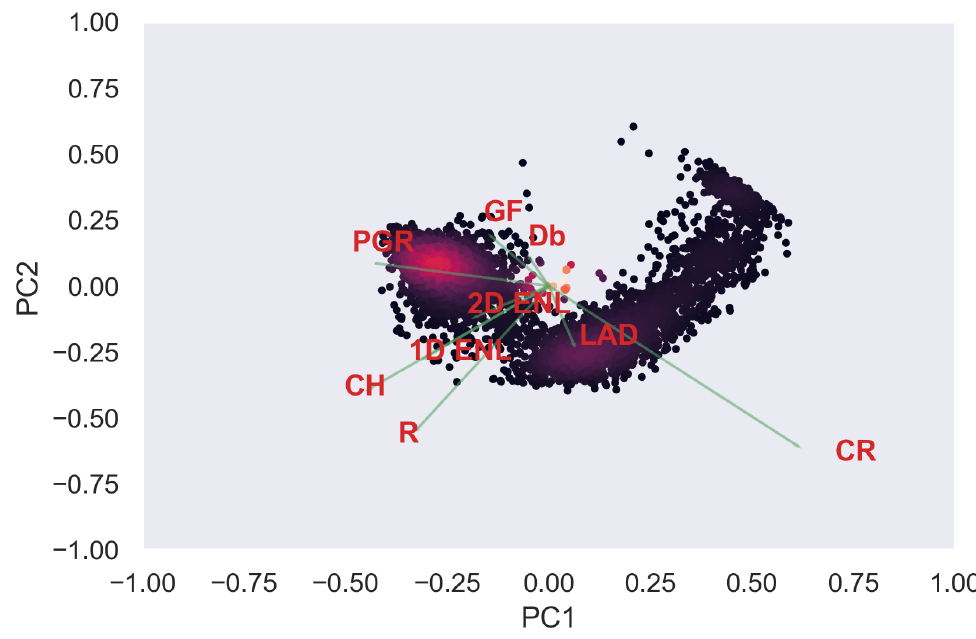
Figure A33. ULS PCA band 1 and 2 loadings at 1m grid size.